Question: In one sentence, what is this figure communicating?
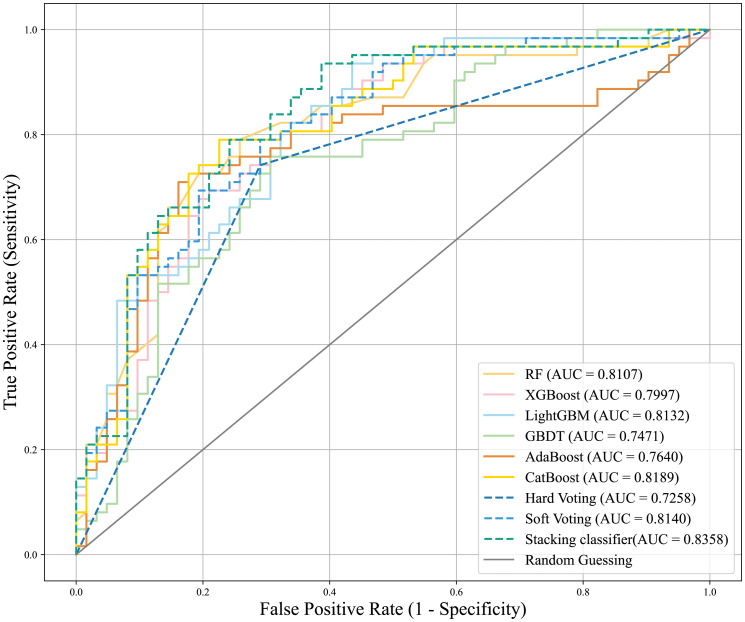
Answer: Receiver operating characteristic curves comparing the predictive performance of the evaluated machine learning models for 3-year OS.